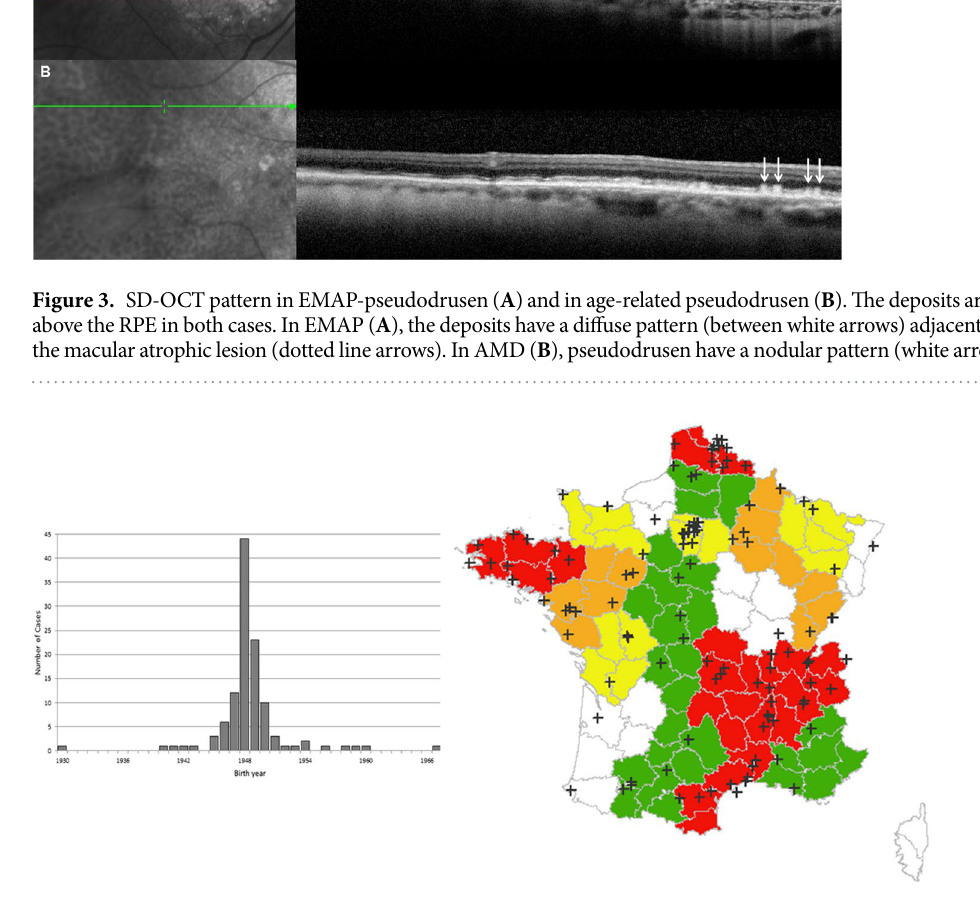
patients according to their birthplace. The disease incidence is high in regions with industrialized or farming activities (in red). Disease incidences (per 10 6 inhabitants): White no case, Green 1 to 2, Yellow 2 to 5, Orange 5 to 10, Red > 10. The French map with permission from http://jfbradu.free.fr/cartesvect/fdcfrance.htm. This map was modified with Microsoft Paint, version 6.3 (2013, Microsoft Corporation, Redmond, Washington, USA).